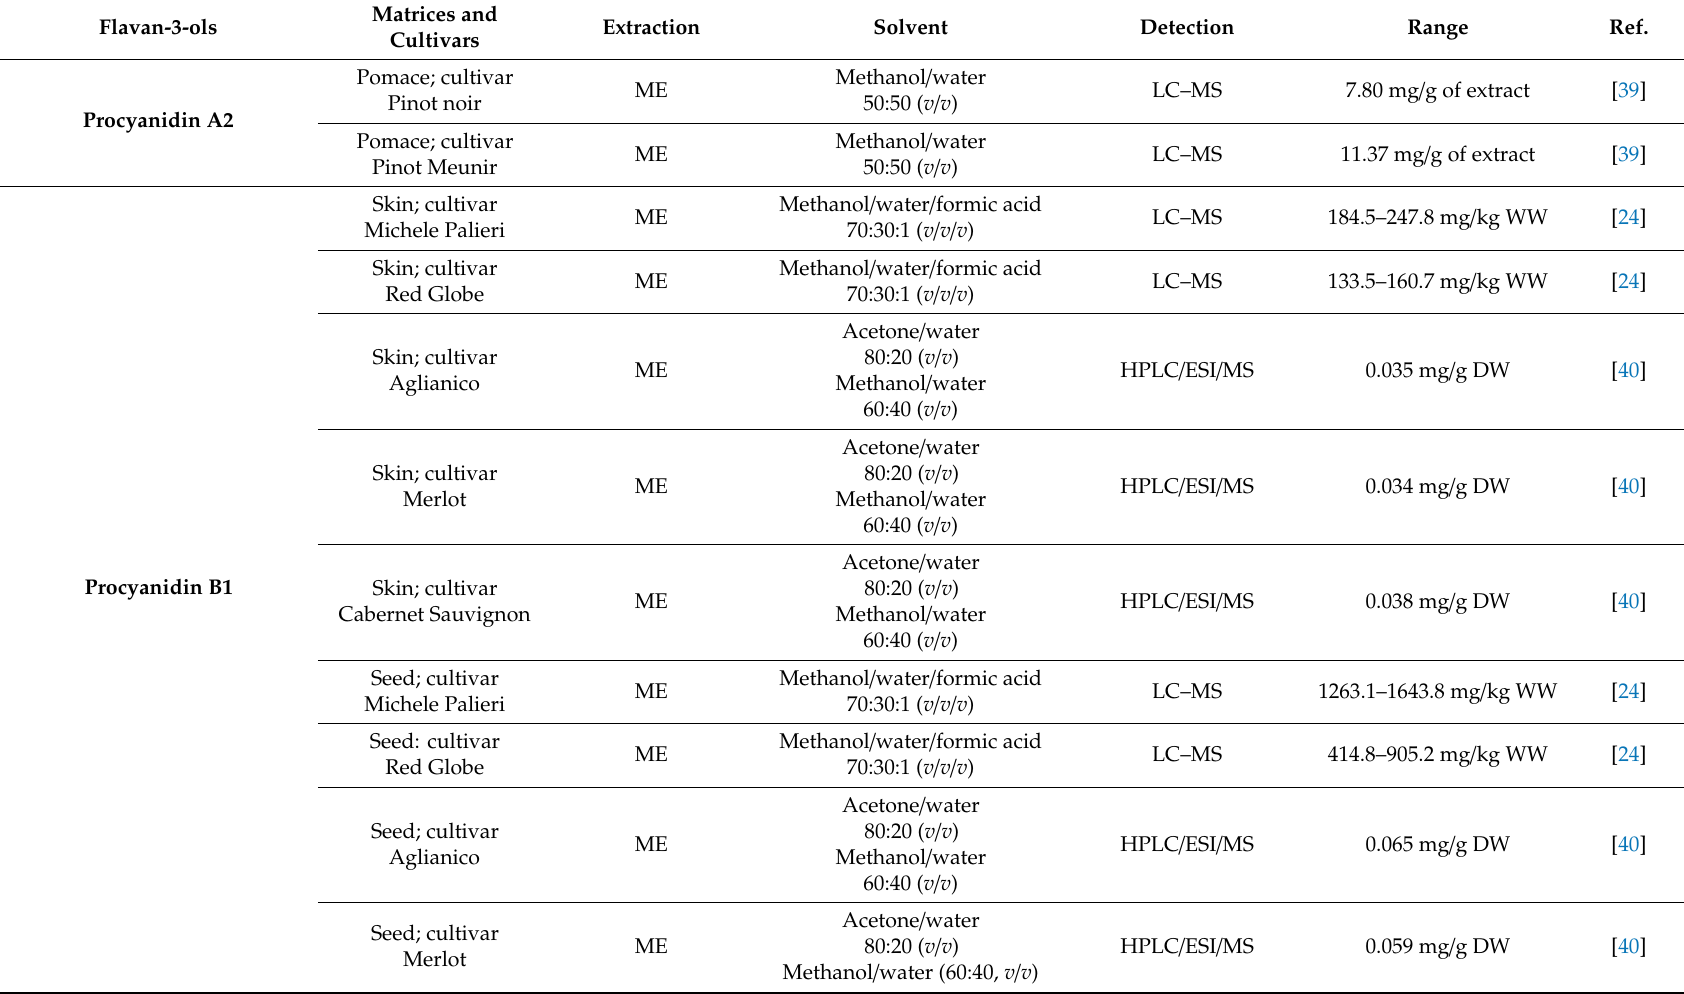
Table 1. Extraction methods, solvent and yield of main procyanidins and total flavan-3-ols obtained from di ff erent V. vinifera